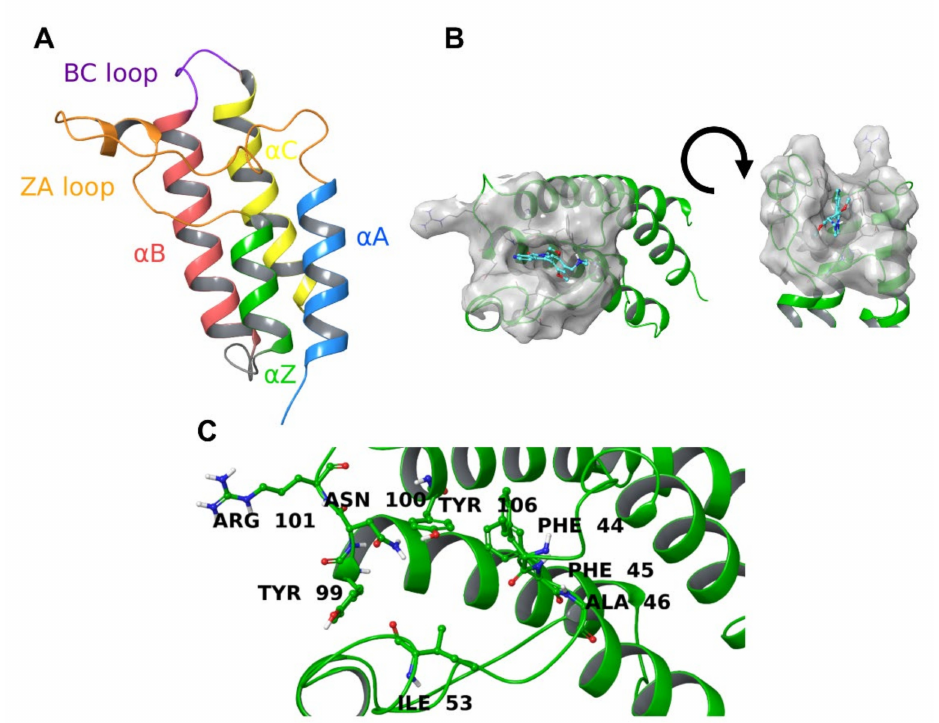
Figure 1. ( A ) Structure of BRD9 protein. Chains and loops are colored in different colors and named accordingly. ( B ) Binding site of BRD9 (PDB: 5F1H [15]). The co-crystallized ligand is in cyan, and the protein is represented by green ribbons with the molecular surface truncated at 7 Å from the ligand. ( C ) Key amino acids of BRD9 binding